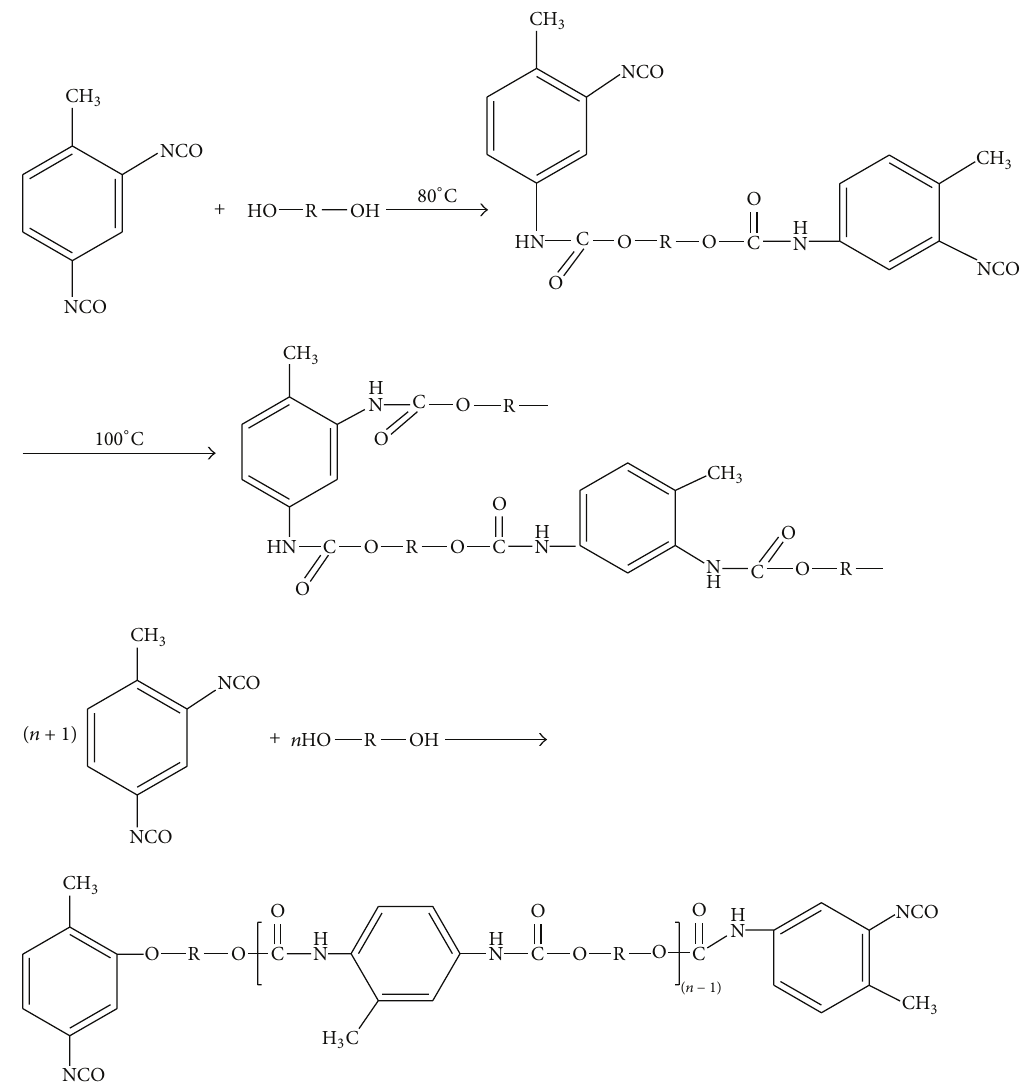
Scheme 1: The reaction equation of performed polymer in the